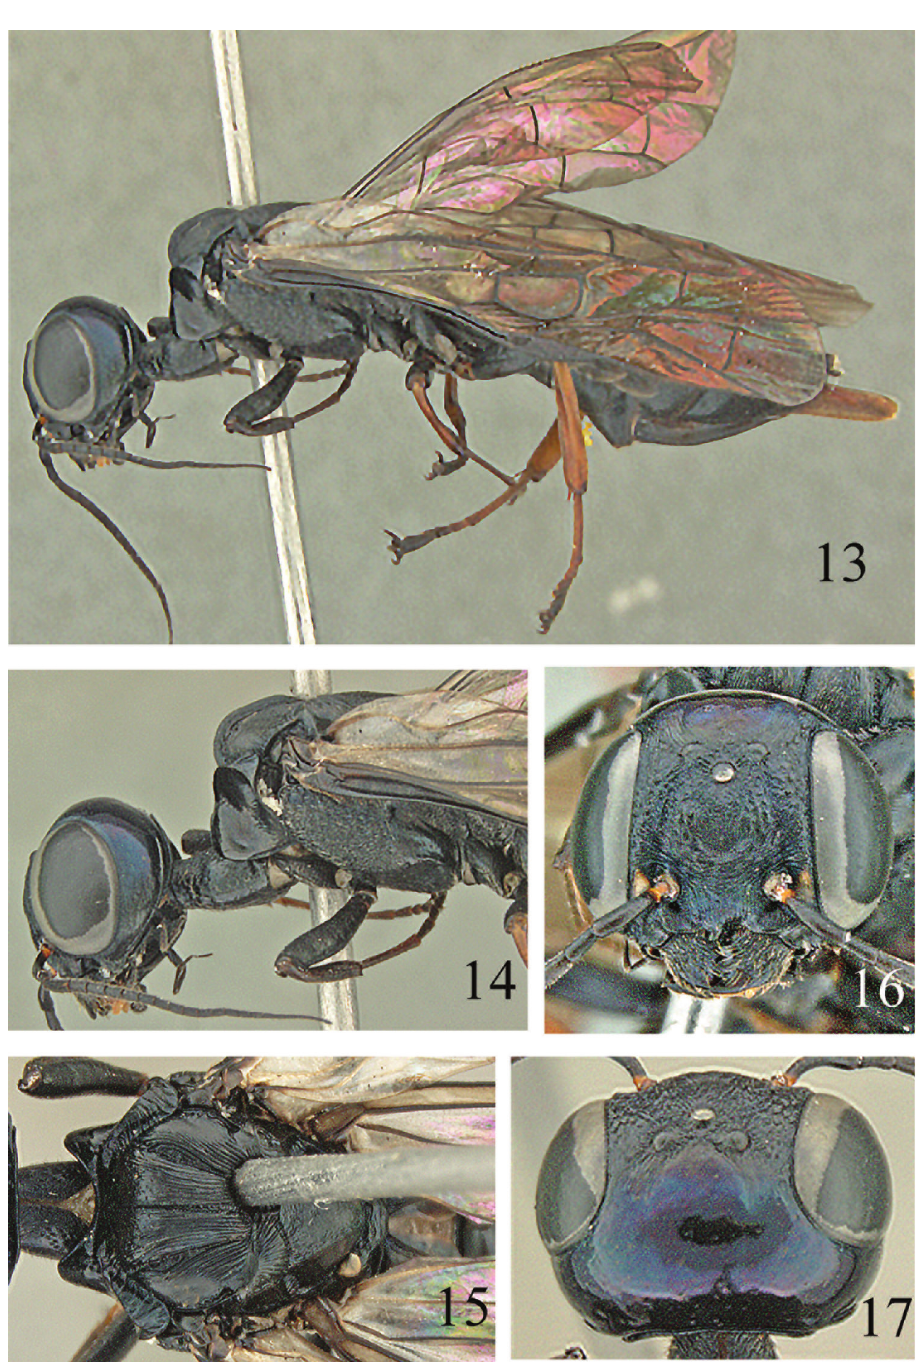
Figures 13–17. Calexiphyda caledonia . 13 Lateral 14 Head and thorax lateral 15 Thorax dorsal 16 Head front 17 Head